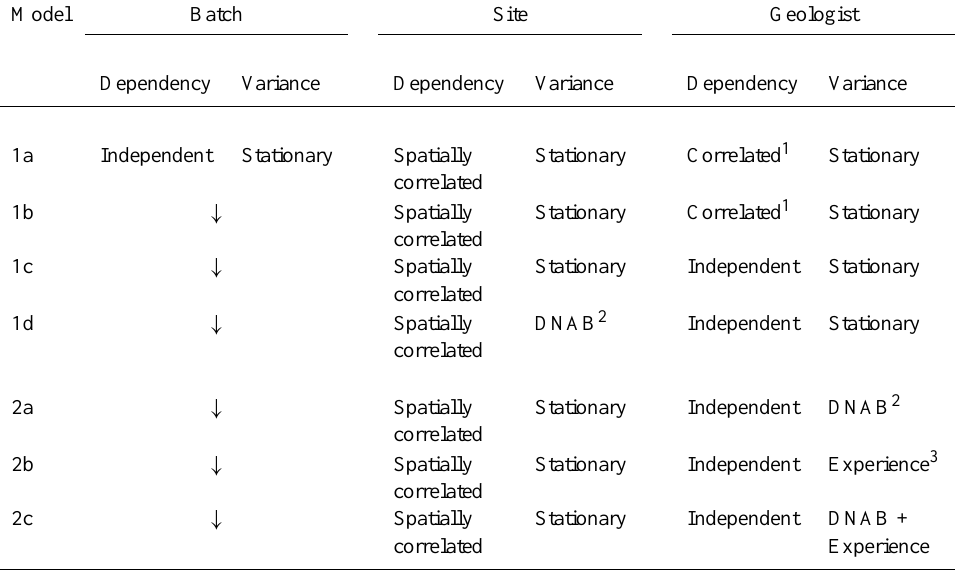
Table 2. Summary of statistical models. In all cases the form of the random effects component for between-batch, between-site and between- geologist effects is indicated. For each term the dependency is given (independent or an indicated correlation structure) and it is indicated whether the variance is constant (stationary) or modelled as a variable quantity. A ↓ indicates that a term is dropped from the model. Model